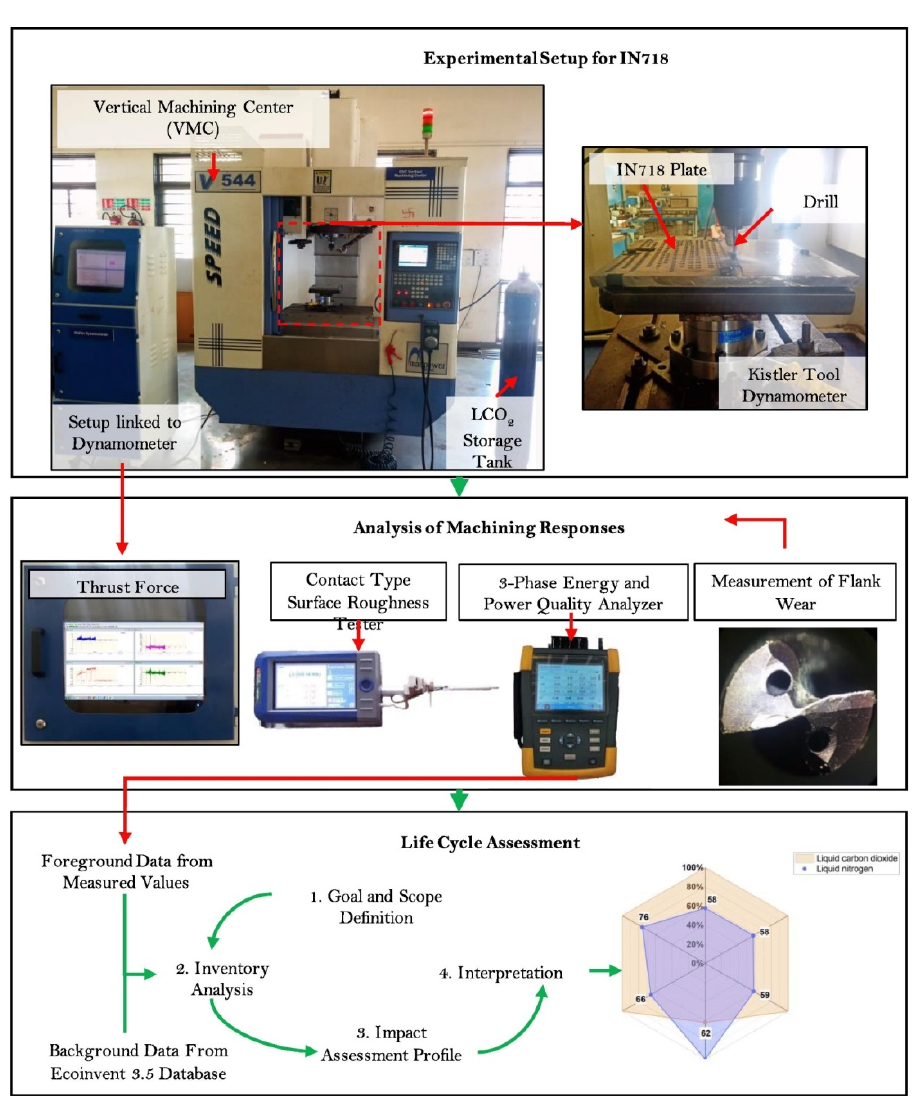
Figure 6. Experimentation methodology followed in the present work [95].